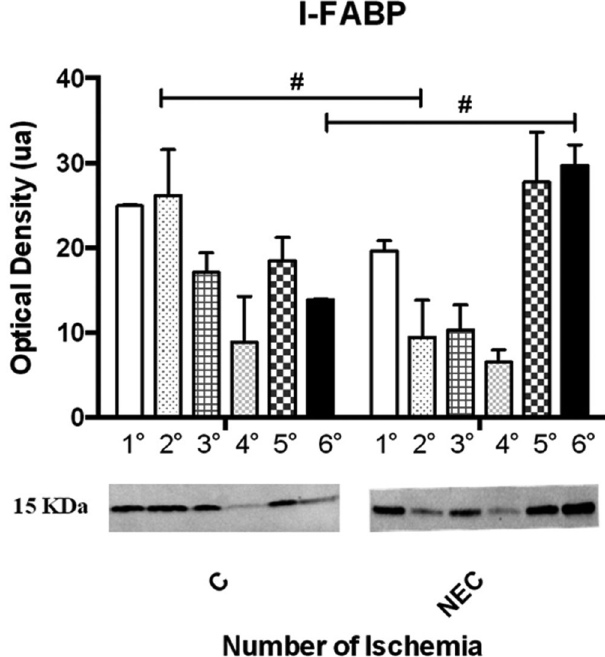
Figure 6 - Western blotting. The mean optical density values of the Western blotting bands for I-FABP (au) at the six experimental time points (numbers correspond to the time points of ischemia) in the C and NEC groups. The molecular weight of I-FABP is indicated. # p o